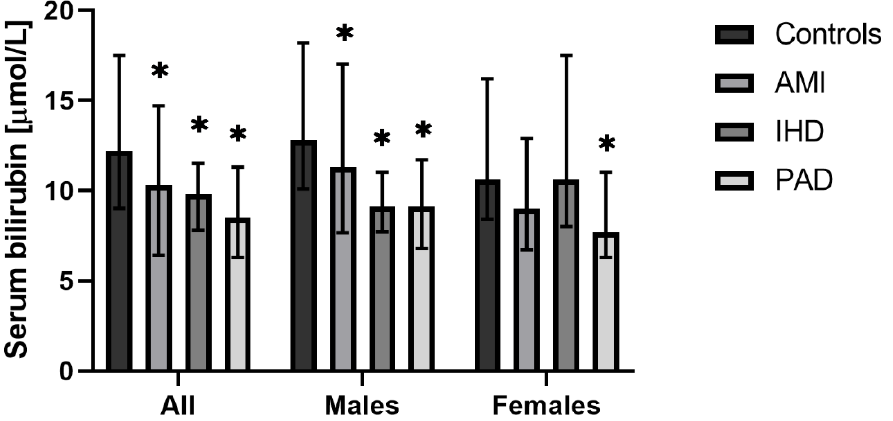
Figure 1. Serum bilirubin concentrations in patients with various forms of atherosclerosis. AMI, premature acute myocardial infarction; IHD, ischemic heart disease; PAD, peripheral artery disease. * p < 0.05, when compared to controls. tially lower bilirubin concentrations were observed across all genotypes in all groups of